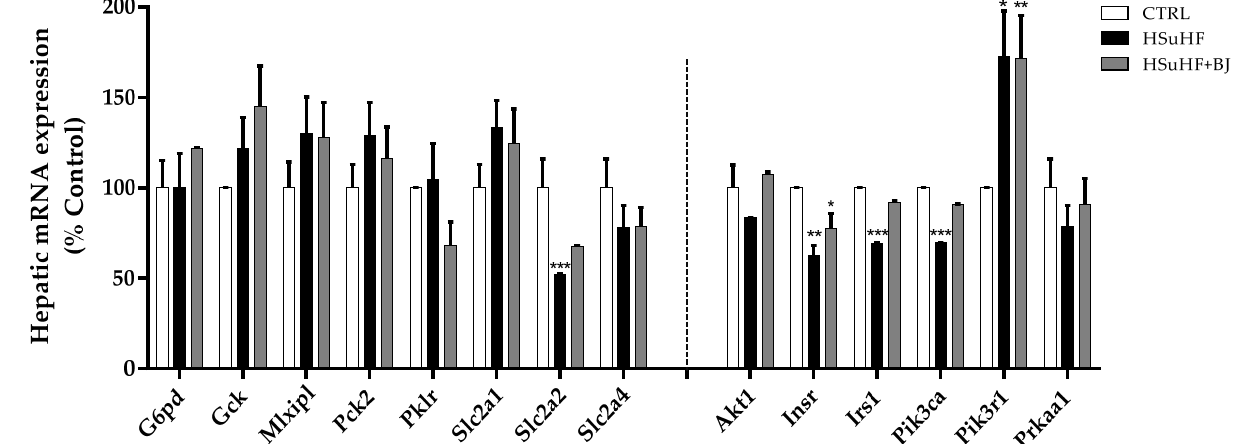
Figure 7. Hepatic mRNA expression of genes related with glucose metabolism and the insulin signaling pathway of CTRL, HSuHF, and HSuHF + BJ groups. Data are presented as mean ± SEM ( n = 6–8/group). * p < 0.05, ** p < 0.01, and *** p < 0.001 vs. CTRL group. CTRL: control. HSuHF: high sucrose / high-fat. BJ: blueberry juice.